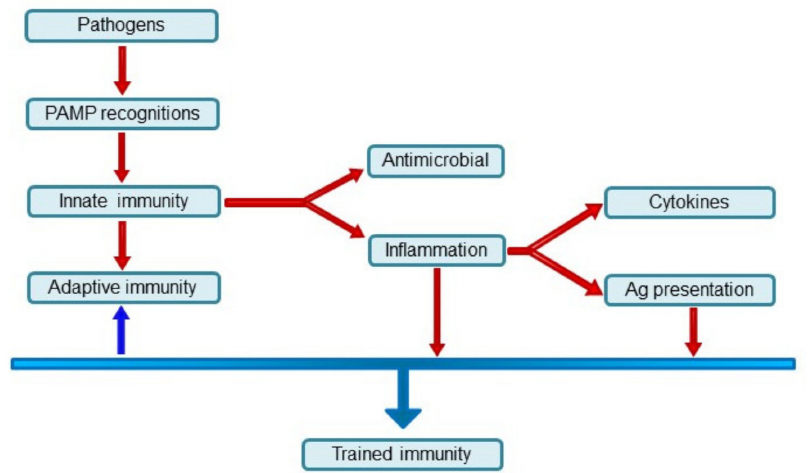
Figure 1. An overview of immune response. PAMP recognition initiates both parts of the im- mune response. Antimicrobial response followed by an inflammatory response plays a role in the development of trained